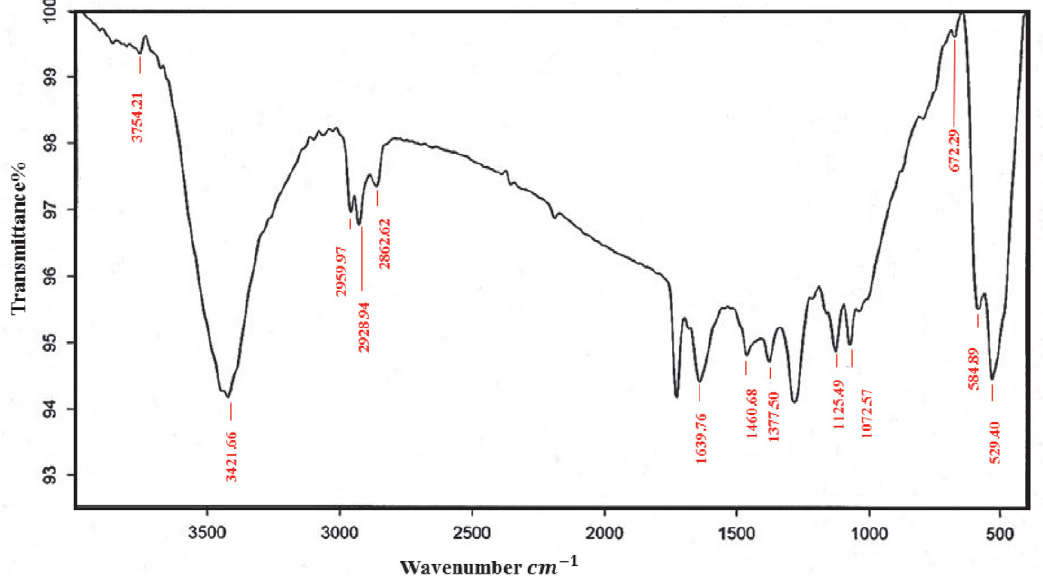
Figure 5 . FTIR spectra of calcinated CuO